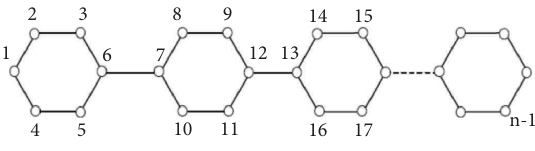
Figure 2: Te armchair chain H [ k ] .